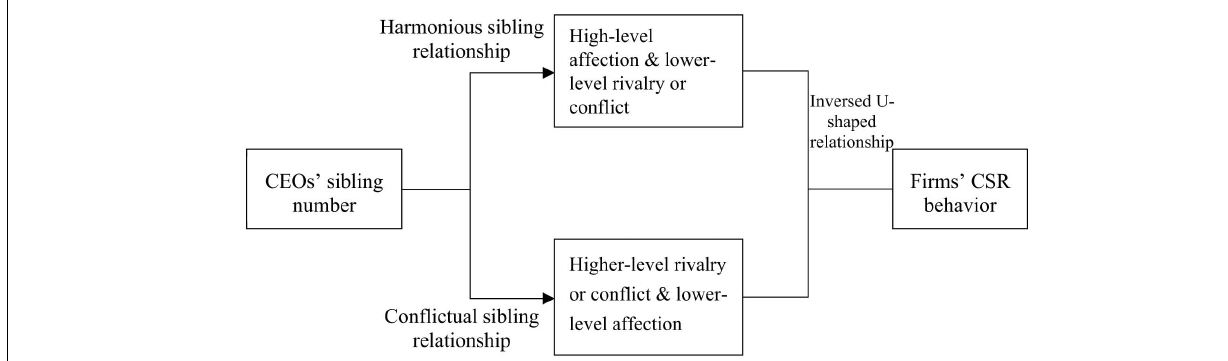
FIGURE 1 | Relationship between CEOs’ sibling number and CSR behavior.